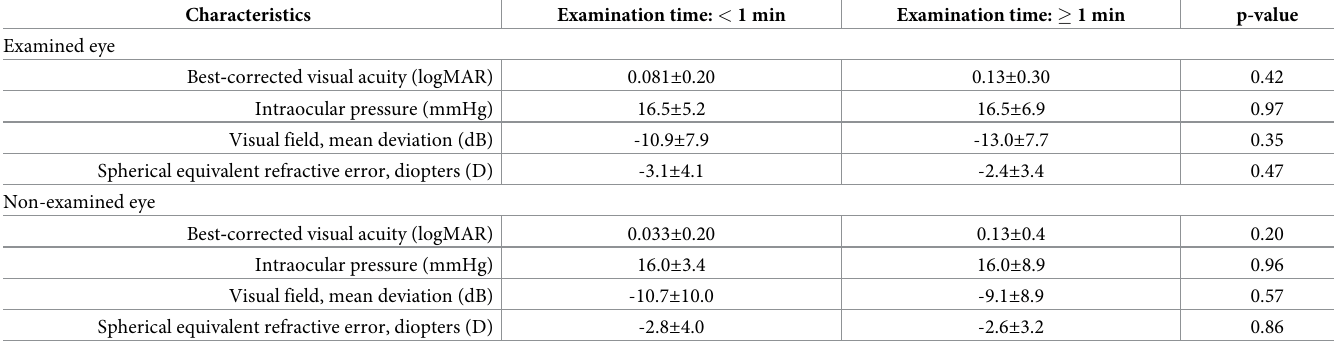
Table 4. Subgroup comparison of clinical characteristics of the patients between examinations lasted for < 1 min and � 1